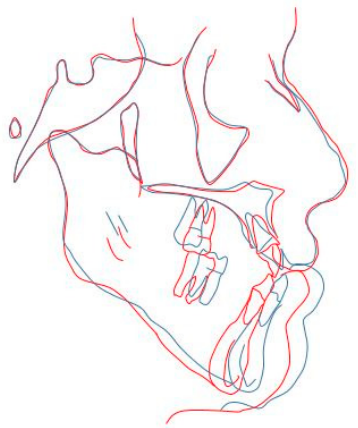
Figure 1. Super-imposition of pre- and post- and traced cephalometric tracing showing advancement of the maxilla and setback of the mandible [10].